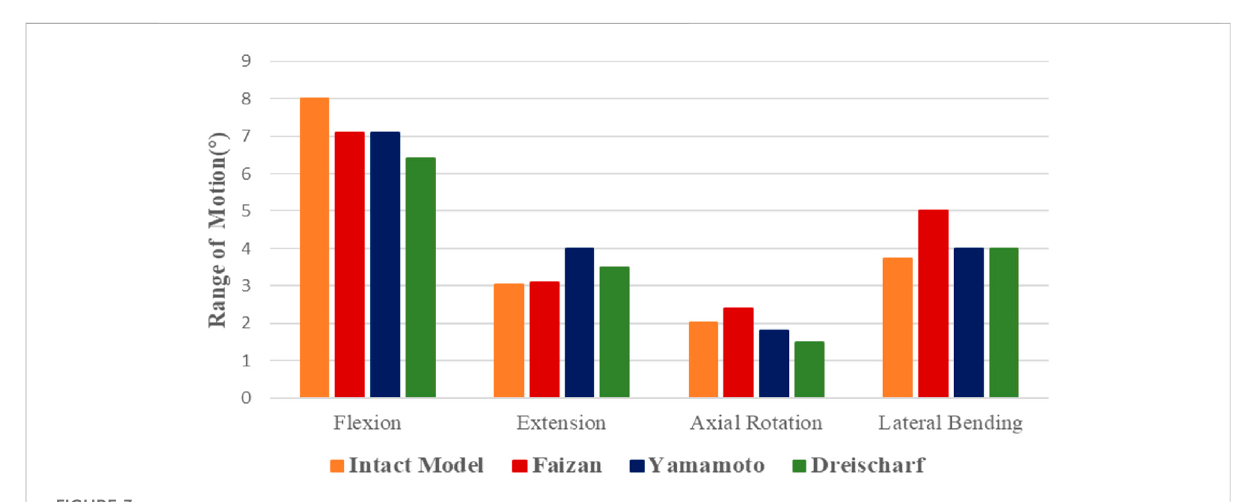
FIGURE 3 The ROM of the intact model was compared with other